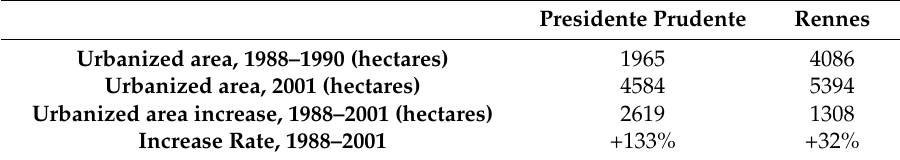
Table 1. Urban growth rate of Presidente Prudente and Rennes between 1988–1990 and 2001.